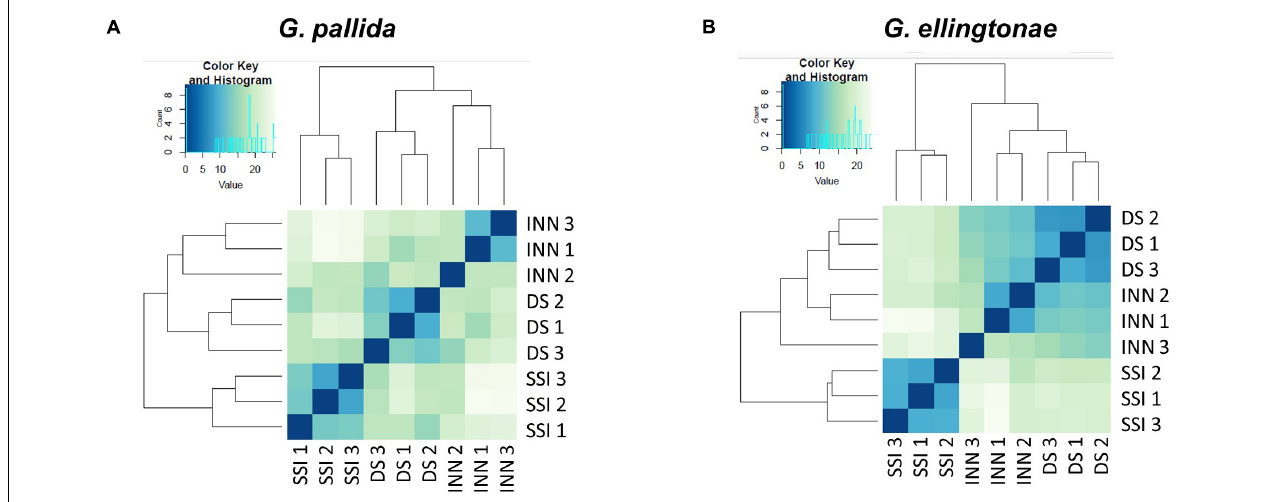
FIGURE 5 | Heatmaps showing the similarity of the different transcriptome libraries for (A) Globodera pallida and (B) Globodera ellingtonae . Euclidean distance between samples is based on normalized read counts from DESEQ2 clustered using the heatmap function in R. The darker blue color indicates a closer correlation of expression levels between RNA-seq libraries. Three biological replicates were used for each hatching condition: DS – susceptible potato variety cv. Desirée, SSI – immune plant S. sisymbriifolium , and INN – resistant potato variety cv.